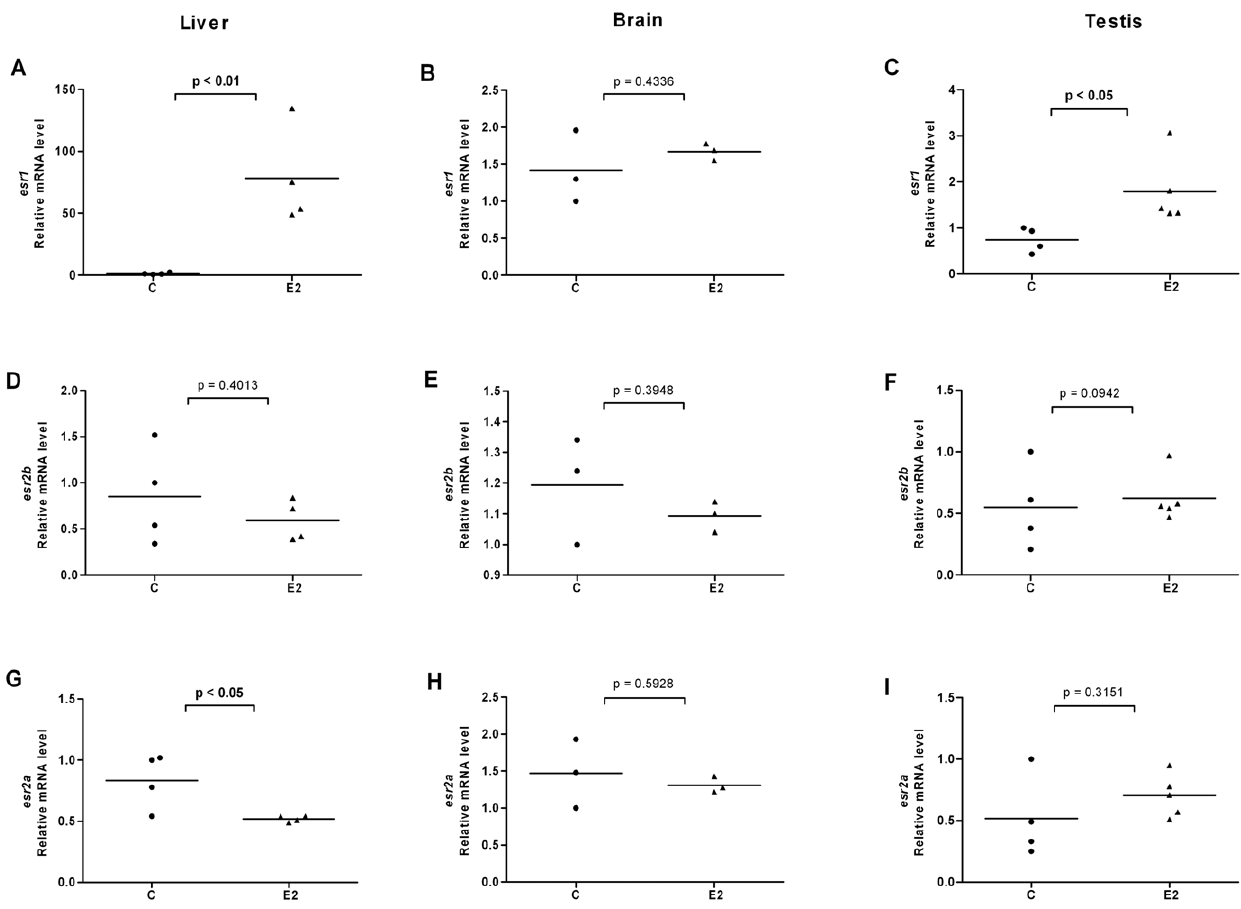
Figure 5. Effects of 17 b -estradiol on esr expression in liver, brain and testis of male fish. Expression levels of esr1 (A–C), esr2b (D–F) and esr2a (G–I) in liver, brain and testis of male zebrafish following exposure to E2 (1 m M). Normalization and mean values were calculated as in figure 4.